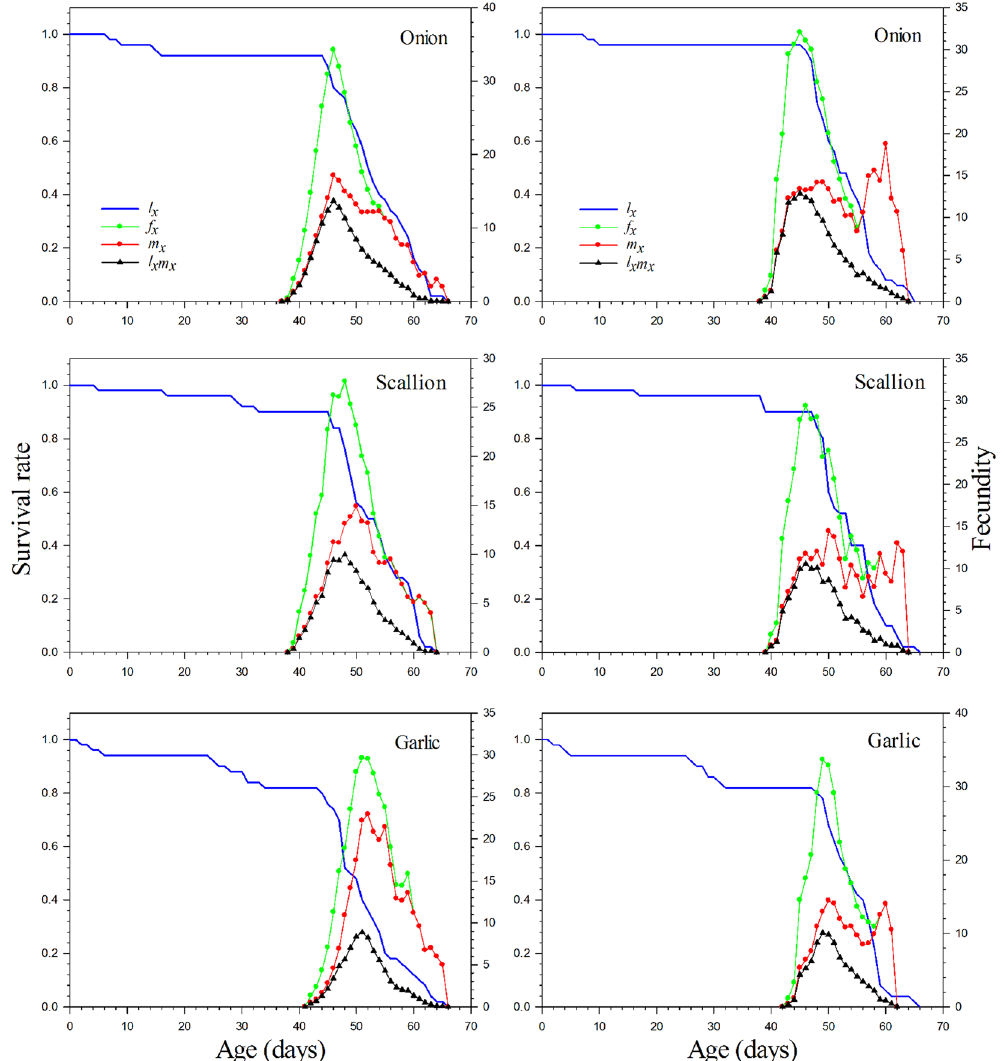
Figure 2. The age-specific survival rate ( l x ), female age-specific fecundity ( f x ), age-specific fecundity ( m x ), and age-specific maternity ( l x m x ) versus age of Delia antiqua on different host plants. Left: Individually reared method; Right: Group reared method.